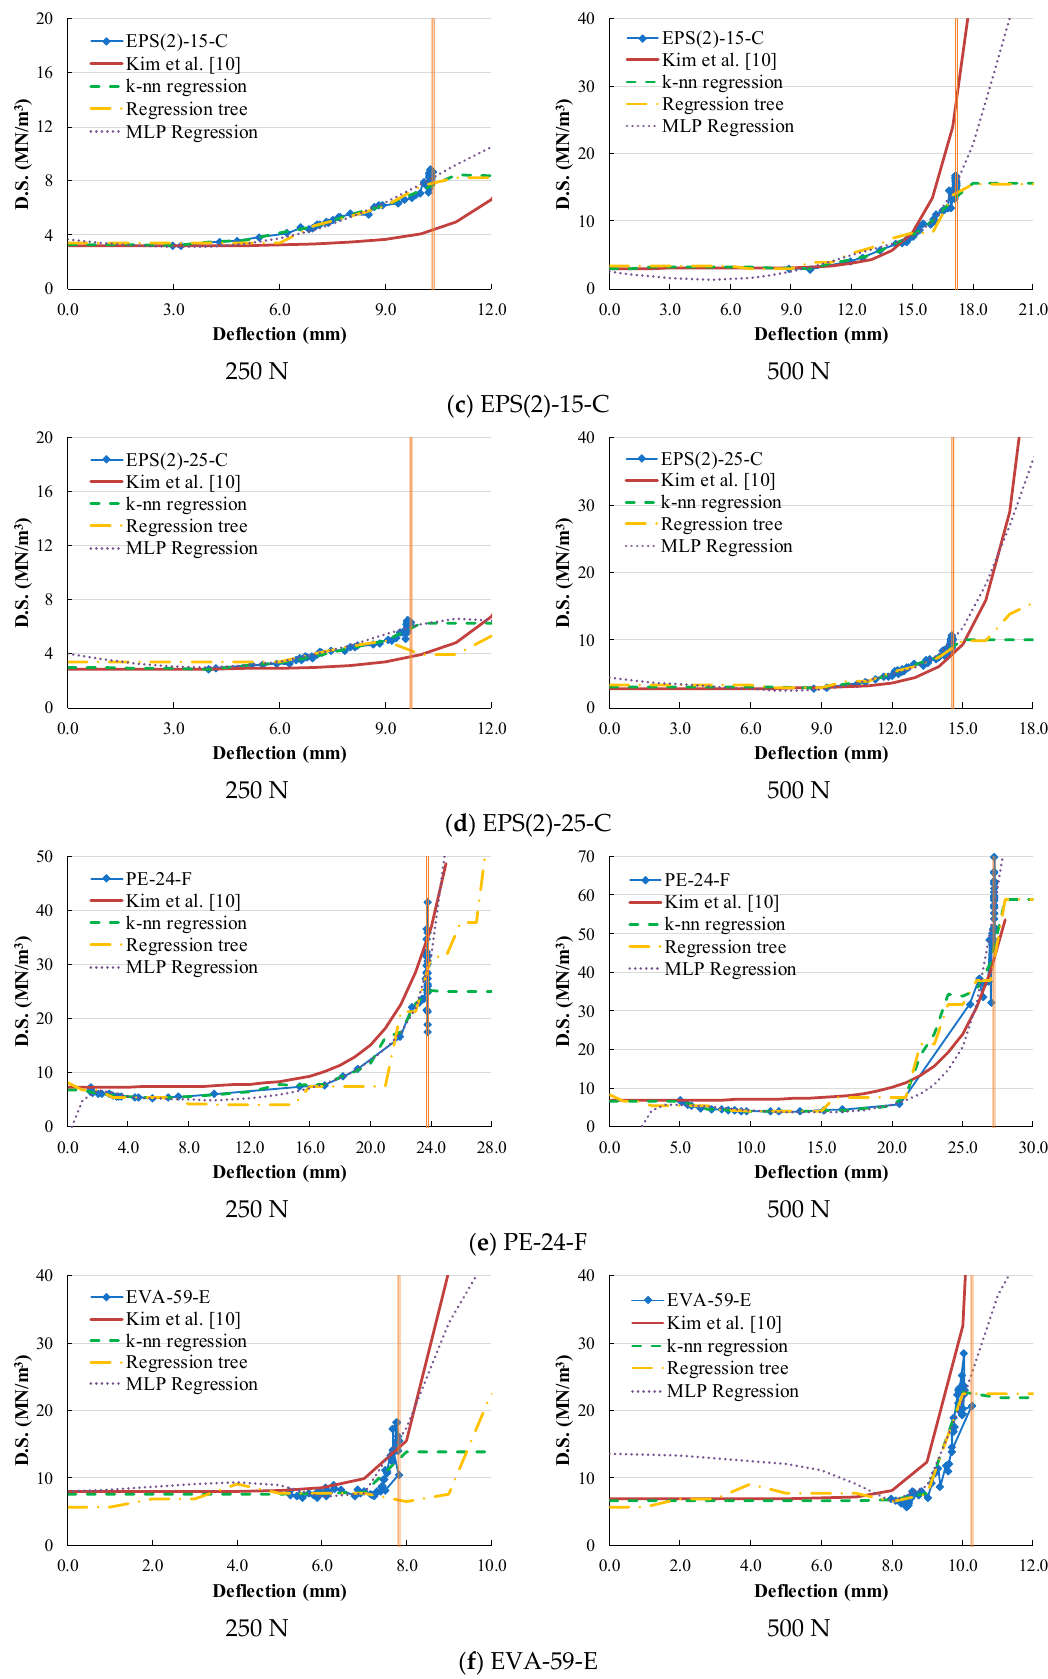
Figure 6. Dynamic stiffness comparisons between the test results and the equation for 250 N and 500